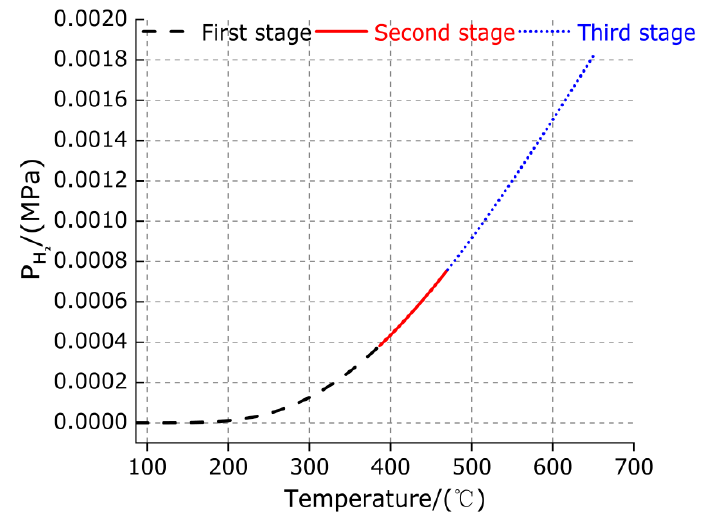
Figure 11. The variation curve of equilibrium hydrogen pressure of decomposition for TiH 2 in three stages with temperature.